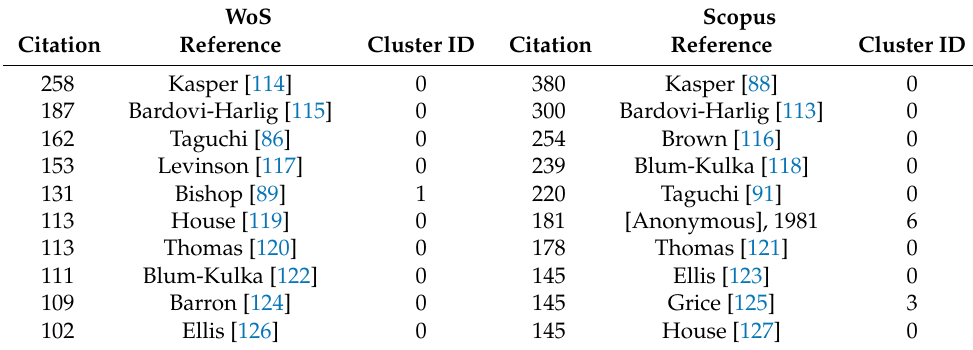
Table 7. Top citations counts for pragmatic language